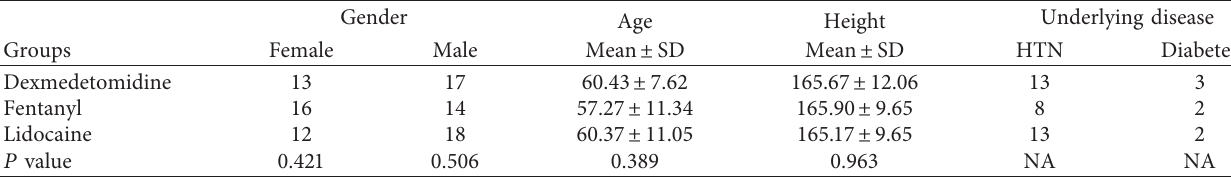
Table 1: Demographic information of participants.